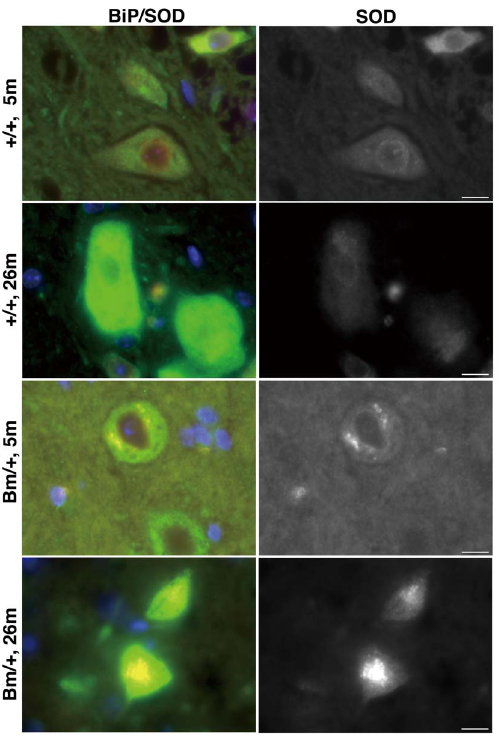
Figure 4. Aggregations were obvious in the aged mutant BiP mouse. The aggregations were evaluated by immunofluorescence microscopy with double labeling by using a rabbit anti-SOD1 antibody (red) and a mouse anti-KDEL mAb for the wild type BiP and other ER chaperones (green, + / + , 5 and 26 month-old), or by using a rabbit anti- SOD1 antibody (red) and a mouse anti-HA mAb (15E6) for the mutant BiP (green, Bm/ + , 5 and 26 month-old). Scale bars, 10 um. Aggregations were observed in large cells at the anterior horn of a 26-month-old mutant spinal cord (Bm/ + , 26 m).